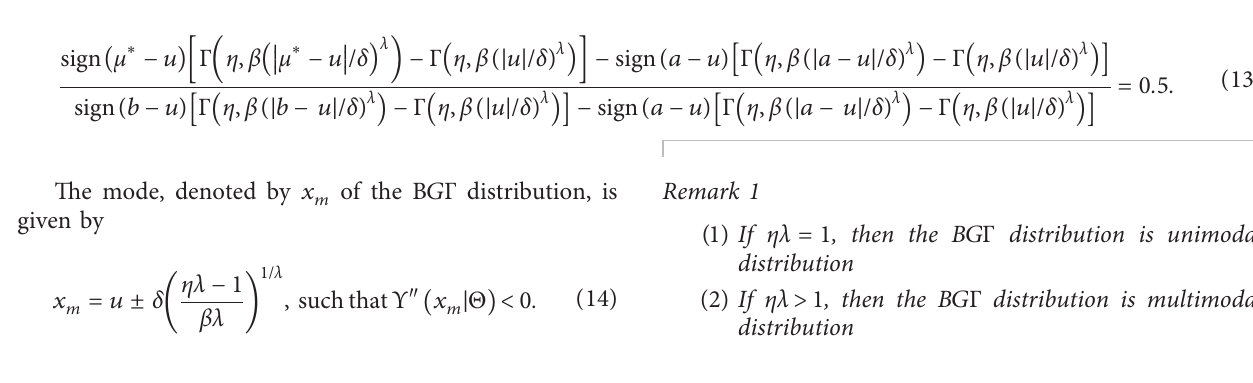
Figure 2: The pdf of B G Γ M for a � − 2, b � 3, u � 1, δ � 1, λ � 2 and (a) β � 2 and η � 0 . 5 , 5 , 7; (b) η � 3 and β � 0 . 5 , 1 , 10; (c) ( η � 0 . 5 , β � 0 . 5 ) , ( η � 0 . 5 , β � 3 ) , ( η � 3 , β � 0 . 5 ) and ( η � 4 , β � 4 )